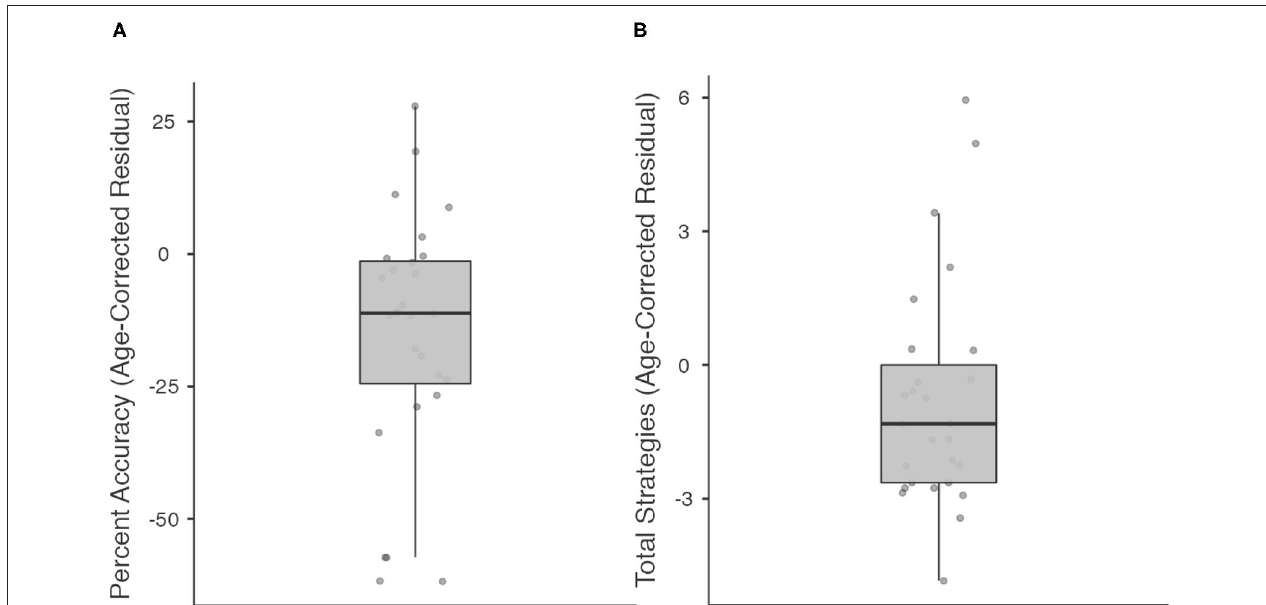
FIGURE 4 | Boxplots showing median, interquartile range, range, and individual datapoints of stroke patient residual scores (raw score—age-predicted score) for percent accuracy (A) and total strategies (B) , in patients deemed to have “normal” cognitive function on the Montreal Cognitive Assessment. Median/interquartile range of residual scores are below age